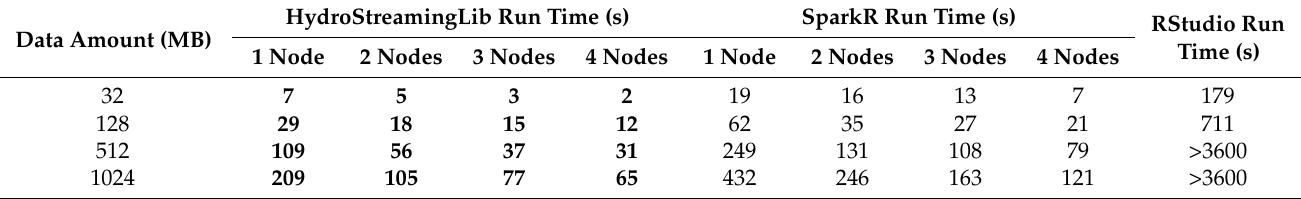
Table 7. Calculation time of K–S test algorithm on HydroStreamingLib, SparkR, and RStudio.